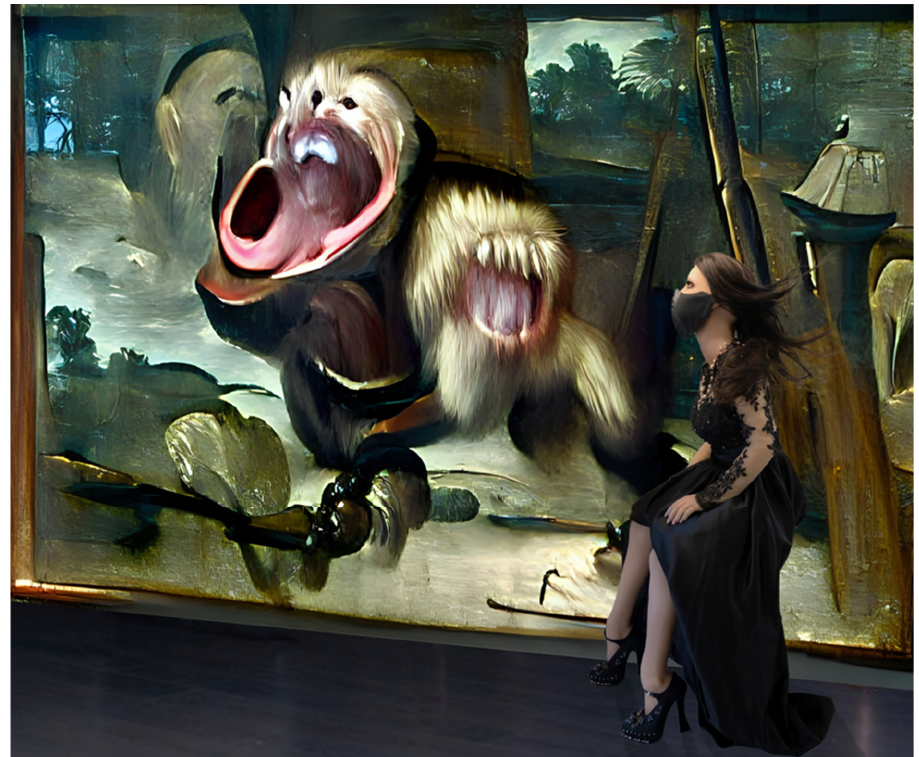
Figure 9. Madeleine + Simians, cyborgs and women. By Graeme Revell, 2022. Photograph, GPT- 2/DALLE-E2 image and text.